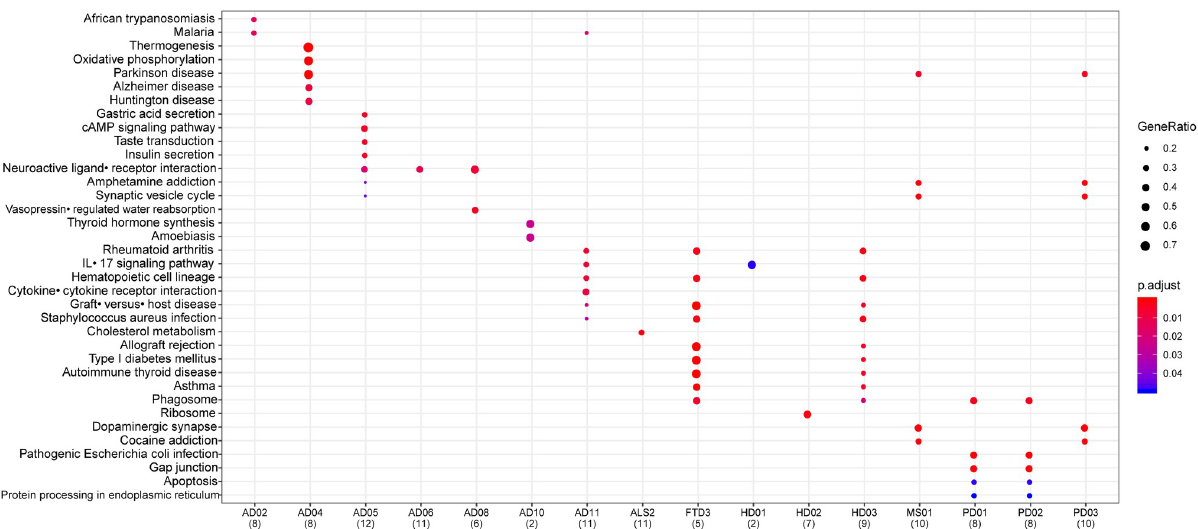
Fig 7. KEGG pathway enrichment analysis for differentially expressed genes. Each row represents a KEGG pathway associated with the diseases shown in columns. The domination of genes in the pathway indicated by the dimension of the circles and the range of the circles represents the statistical validation for p-value =